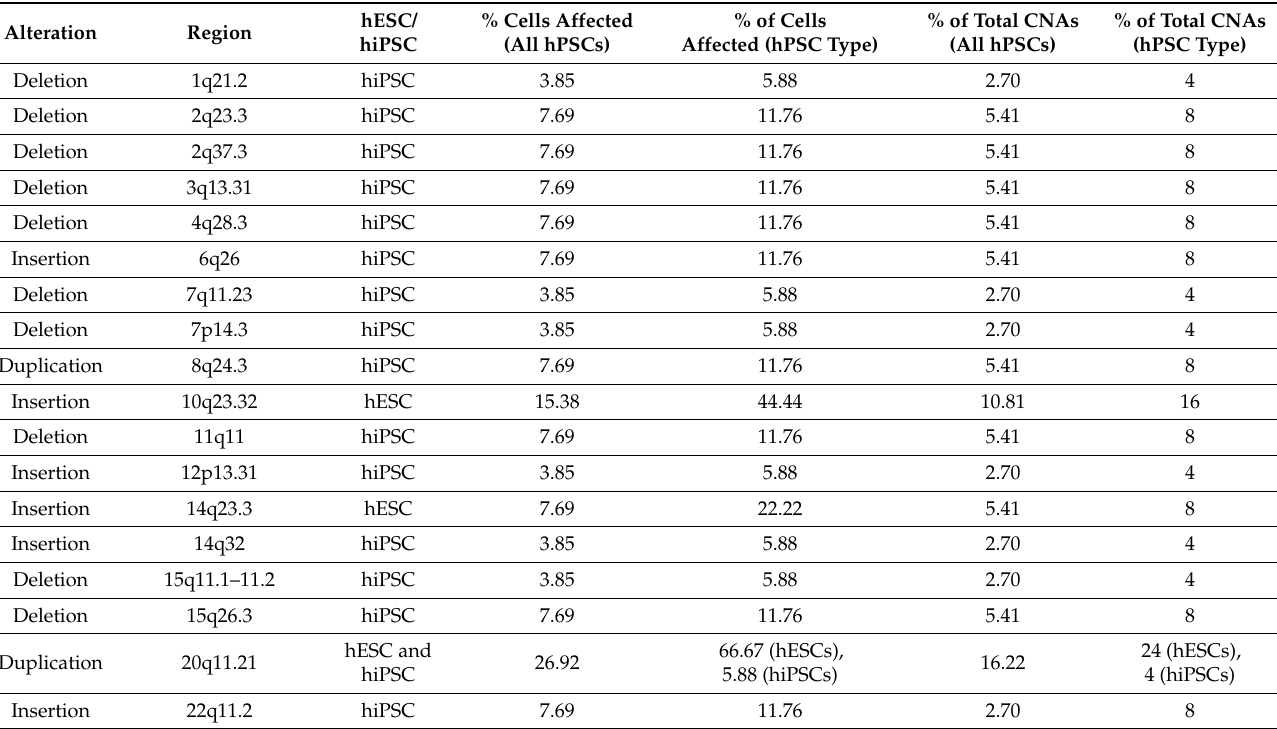
Table 4. List of Copy Number Alterations (CNAs) detected by aCGH in hESCs and